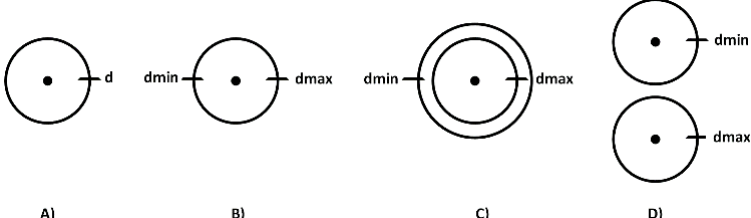
Figure 2. The core composition synthesis of the medieval castle approach. ( A ) is a simple system with one door. ( B ) features two doors at the same layer. ( C ) has two doors at sequential layers. ( D ) illustrates two castles where the attacker can target only one of them for a specific attack.